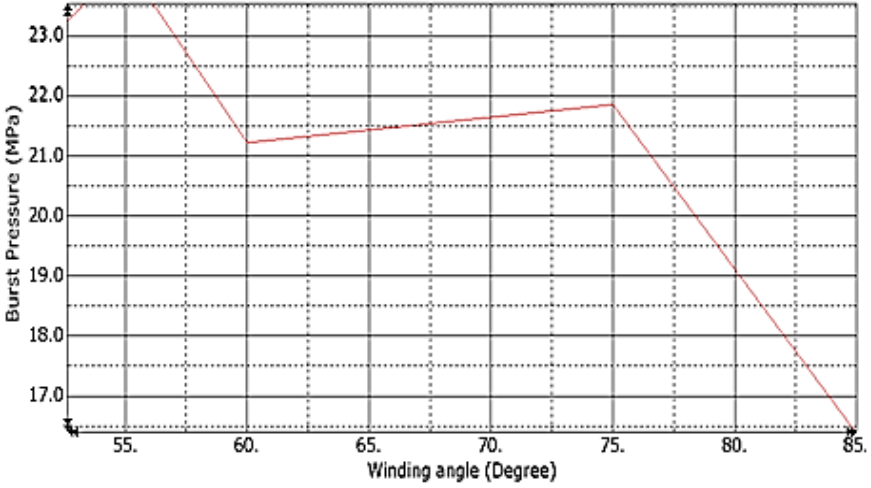
Figure 15. Variation of average burst pressure with winding angle.